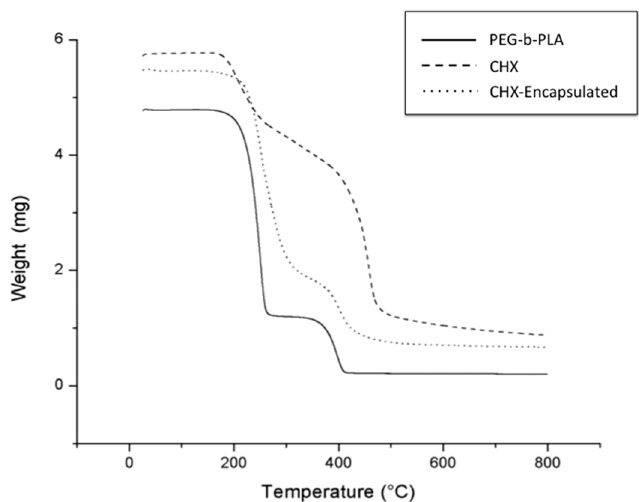
Figure 2. Measurements of the amount of weight change of PEG– b –PLA, chlorhexidine (CHX), and CHX-encapsulated. Thermogravimetric analysis (TGA) curves showing mass loss as a function of temperature. Note that thermal transitions for the CHX-encapsulated product most resemble the behavior and transitions measured for the PEG– b –PLA polymer due to the proportion of PEG– b –PLA being much higher than CHX.